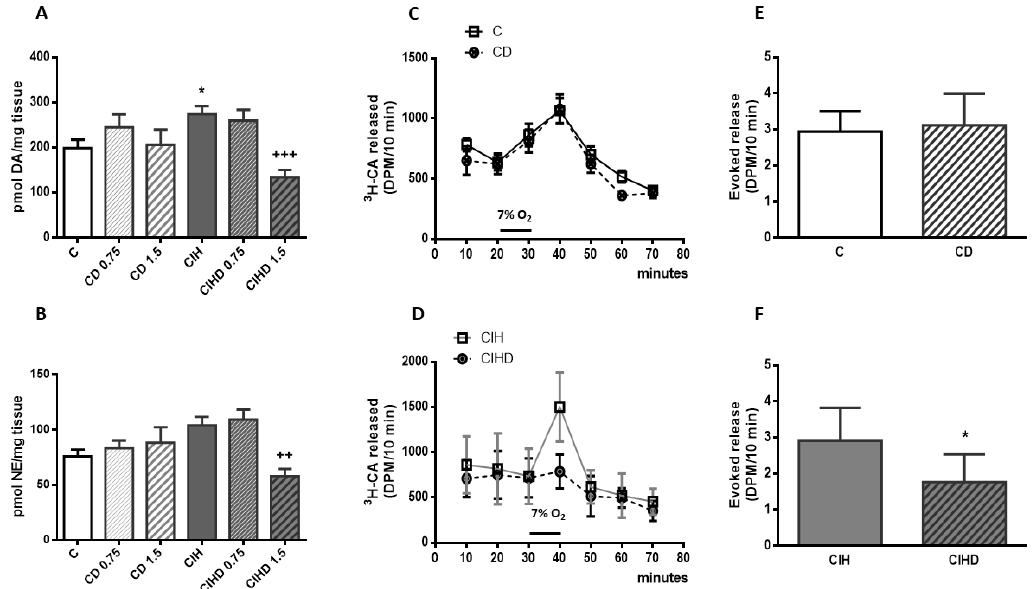
Figure 3. Carotid body catecholamine content and secretory activity. In ( A , B ) endogenous content of dopamine (DA) and norepinephrine (NE) from C (white bar), C treated with DOM (CD; 0.75 and 1.5 mg / day; 15 days; white striped bars), CIH (gray bar) and CIH treated with DOM (CIHD; 0.75 and 1.5 mg / day; 15 days; gray striped bars). Mean ± SEM from 9—18 individual data; * p < 0.05 vs. C; ++ p < 0.01 and +++ p < 0.001 vs. CIH. One-way ANOVA with Tukey’s multiple comparisons test. In part ( C ), time course of 3 H-CA secretion (DPM / 10 min) elicited by 7% O 2 from C and CD, and in part ( D ) and from CIH and CIHD animals. Data are mean and SD from 6–12 individual data. ( E ) shows the cumulative 3 H-CA hypoxia-evoked release from C and CD and in ( F ) from CIH and CIHD group. Data are mean and SD from 6–12 individual data; p < 0.05 vs. CIH; unpaired t